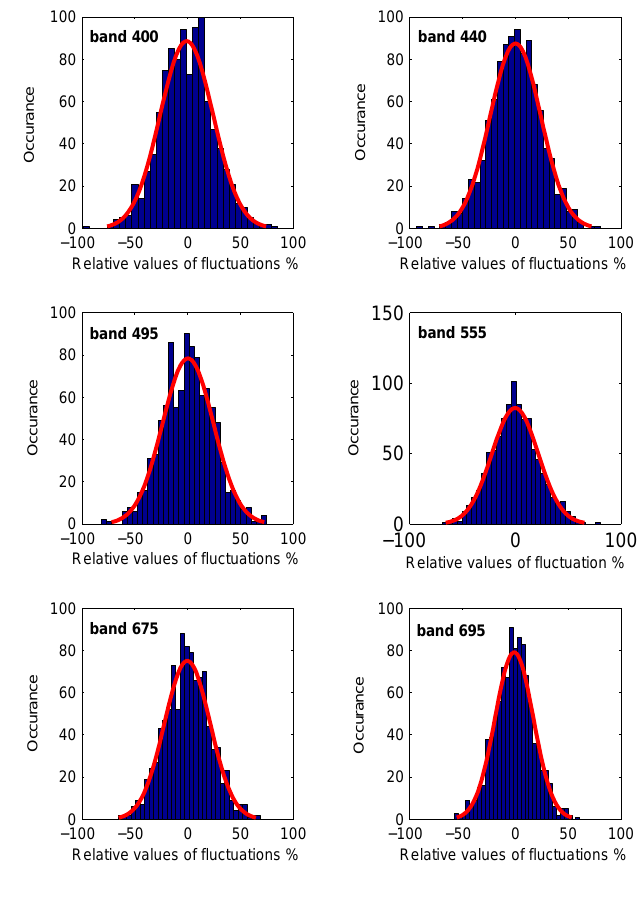
Figure 3. Relative values of fluctuations added to the aerospace mean for six wavelengths.